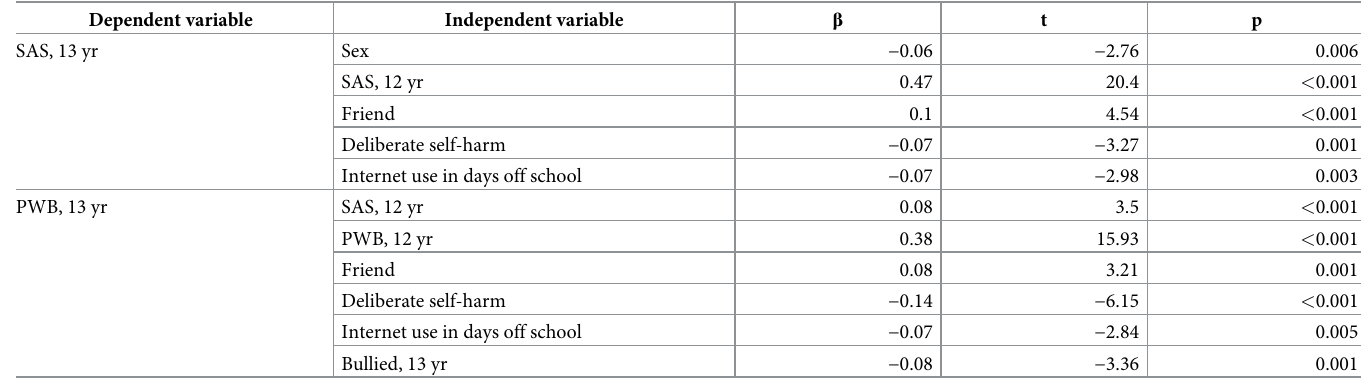
Table 2. Linear regression analysis of association of sex, internet use, being bullied and deliberate self-harm on adolescents’ level of happiness at age 13 years. Dependent